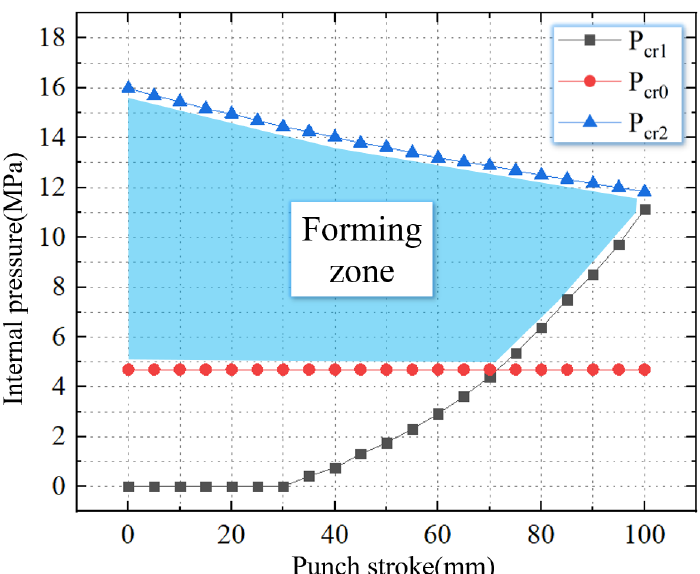
Figure 8. The forming zone of